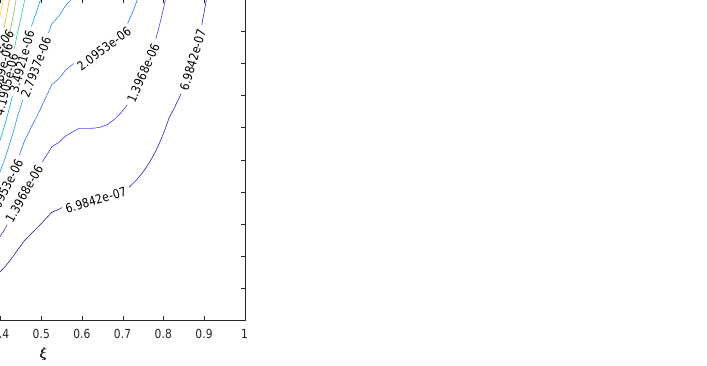
Figure 3. Contour plot of the absolute error of Problem 1 with N = 60, n = 10, M = 26, α = 0.5, and γ =